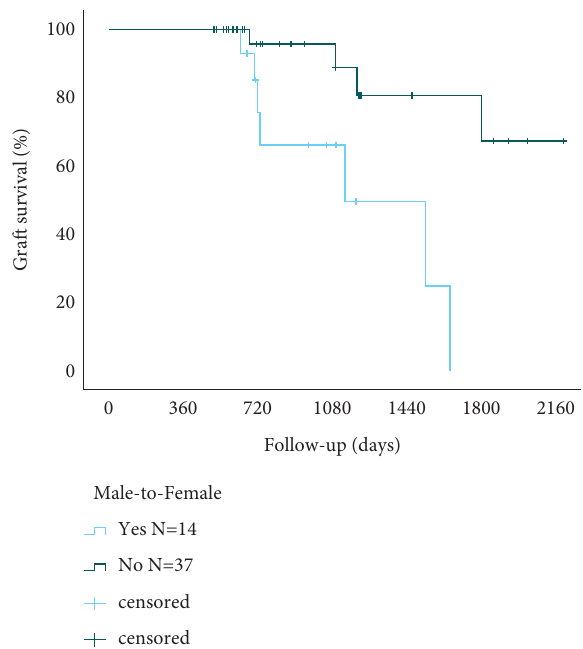
Figure 3: Corneal graft Kaplan–Meier survival curves in male-to- female recipients and other high-risk patients ( p � 0 . 002, log-rank test).